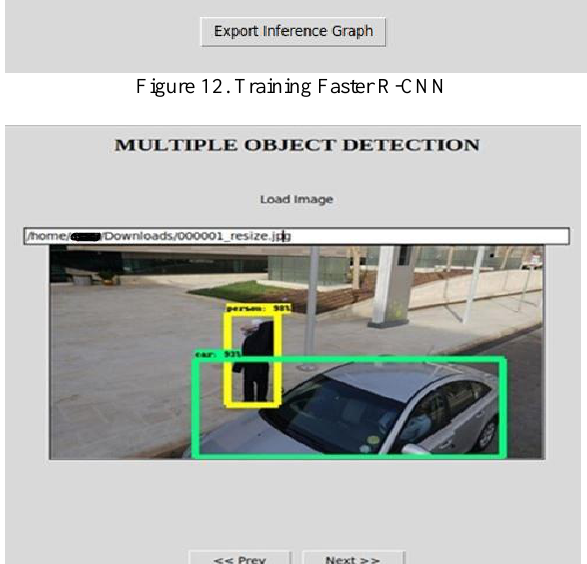
Figure 13. Multiple object detection